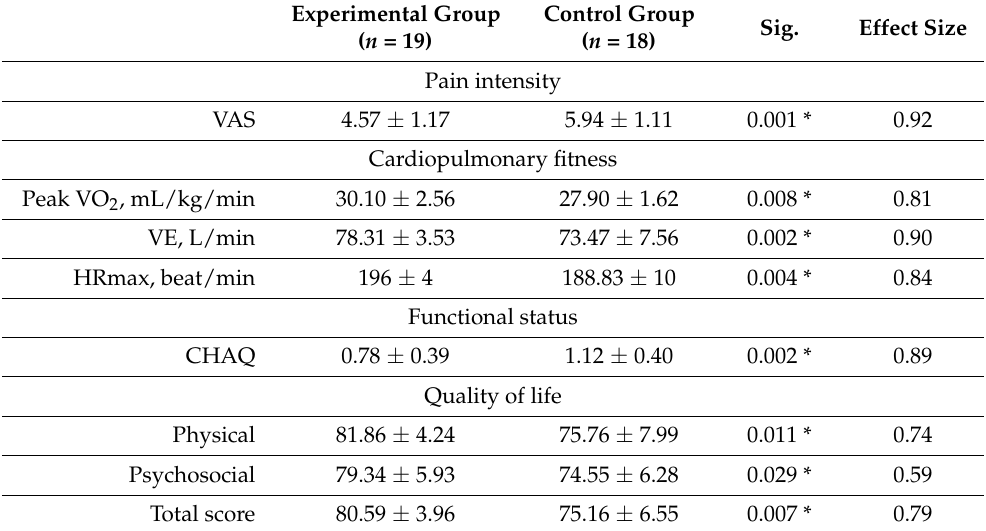
Table 4. Post-treatment differences in primary/secondary outcome measures between the experi- mental and control group: controlled for pre-treatment